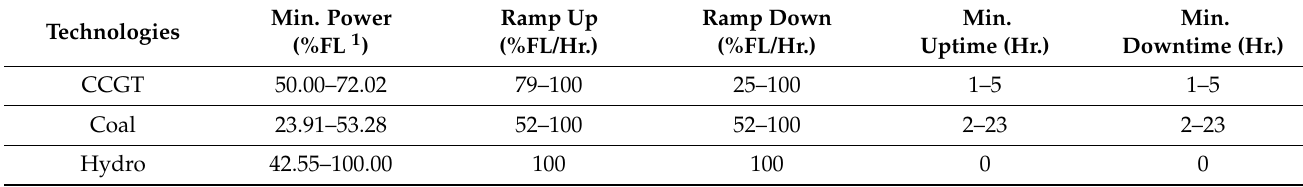
Table 1. Summary of generation characteristics [40].